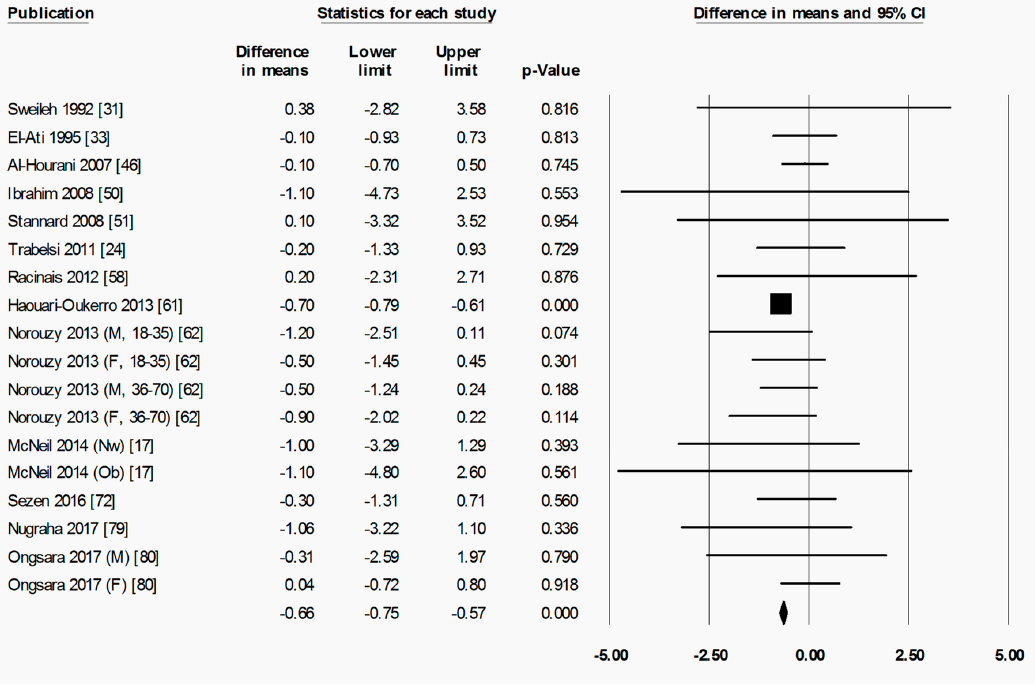
Figure 7. Fat-free mass was significantly decreased by Ramadan fasting. Change in fat-free mass (kg) between pre-Ramadan (pre-R) and the end of Ramadan (post-R). Heterogeneity statistics: T = 0.000, p = 0.753, I 2 = 0.0%. F = female; M = male; Nw = normal weight; Ob = obese; 18–35, 36–70 = age range.